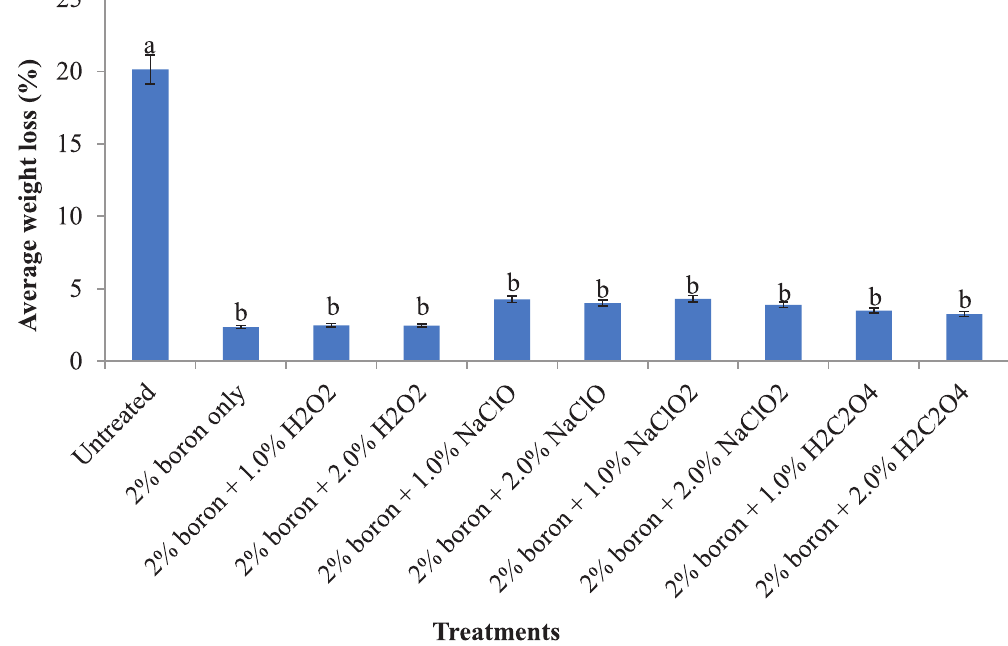
Figure 4 - Inhibition of subterranean termite: Coptotermes curvignathus feeding by treatment of rubberwood O = Hydrogen peroxide, NaCIO = Sodium with different of boron mixture for 28-days exposure (H 2 2 hypochlorite, NaCIO = Sodium chlorite and H C O = Oxalic acid). Means within column followed by the 2 2 2 4 same letter are not significantly different at the 5% level of anOva test. Error bar represents the standard